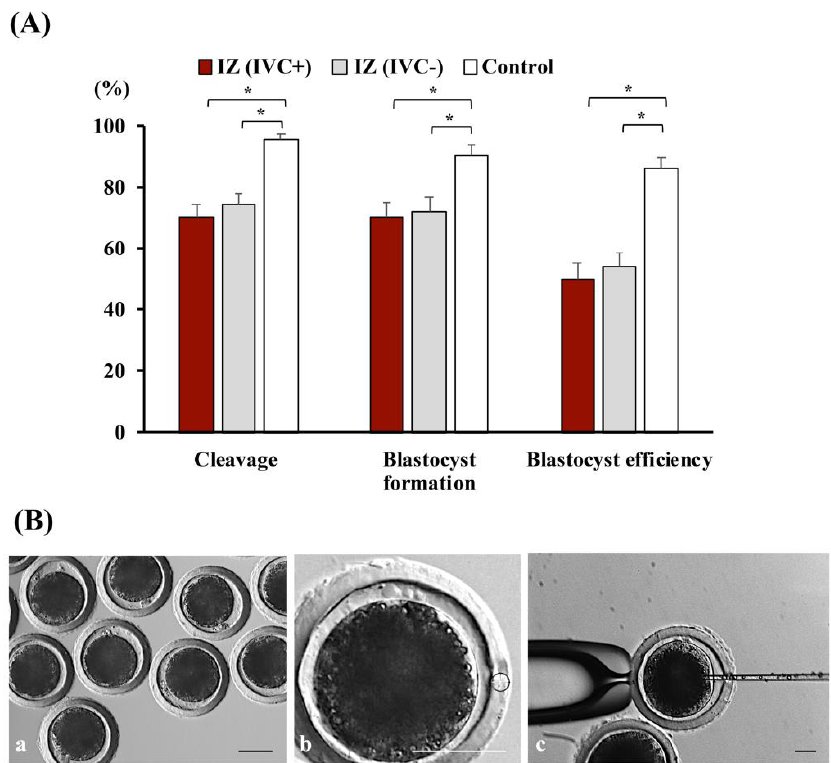
Figure 9. Effect of melatonin on the in vitro development of microinjected zygotes produced in vivo. ( A ) Cleavage, blastocyst formation, and blastocyst efficiency rates of in vivo-derived, injected zygotes (IZ) cultured for 168 h in a culture medium containing (IVC+; n = 217) or lacking (IVC − ; n = 214) 1 nM melatonin. Noninjected in vivo-derived zygotes cultured in the absence of melatonin were used as controls ( n = 65). * p < 0.001. Data are presented as the means ± SEM of six replicates. ( B ) Representative images of in vivo-derived zygotes ( a ) and microinjection procedure ( b , c ). Scale bar: 50 µm.